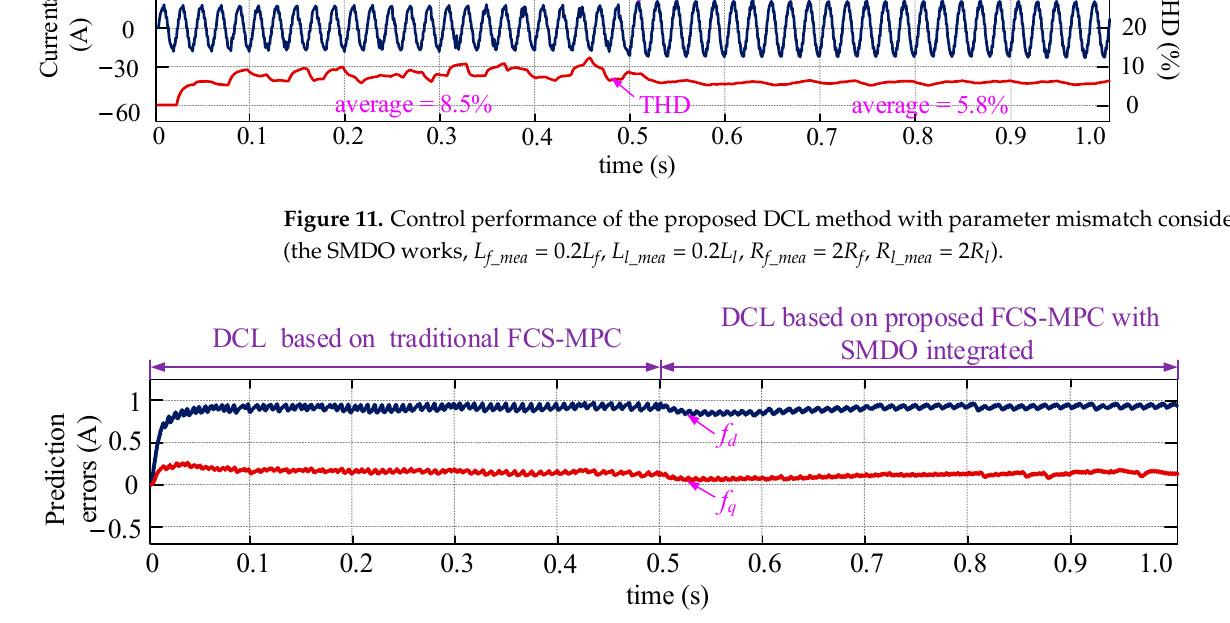
Figure 12. Comparative results of the current prediction errors before and after the proposed SMDO-based MPC method is employed ( L f_mea = 0.2 L f , L l_mea = 0.2 L l , R f_mea = 2 R f , R l_mea = 2 R l ). 4.3.2. L f_mea = 2 L f , L l_mea = 1.5 L l , R f_mea = 0.5 R f , R l_mea = 0.3 R l Assume that the measured filter inductance, line inductance, filter resistance, and line resistance used for the FCS-MPC controller are 4, 3, 0.5, and 0.3 times as large as the real values, respectively. Namely, L f_mea = 2 L f = 0.36 H, L l_mea = 3 L l = 0.3 mH, R f_mea = 0.5 R f = 0.08 Ω , and R l_mea = 0.3 R l = 0.36 Ω . Figures 13 and 14 show the performance of the DCL strategy based on the traditional FCS-MPC and the DCL strategy based on the proposed FCS-MPC with SMDO integrated. Figure 15 shows the current prediction errors. Being different from condition a), the control performance in Figures 13 and 14 is very similar. This happens because, when in this parameter mismatch condition, the prediction errors are pretty small (see Figure 15). It deserves to be mentioned that even the prediction errors are nearly zero, and the proposed technique is able to achieve voltage and frequency-errorless control without sacrificing the control performance.